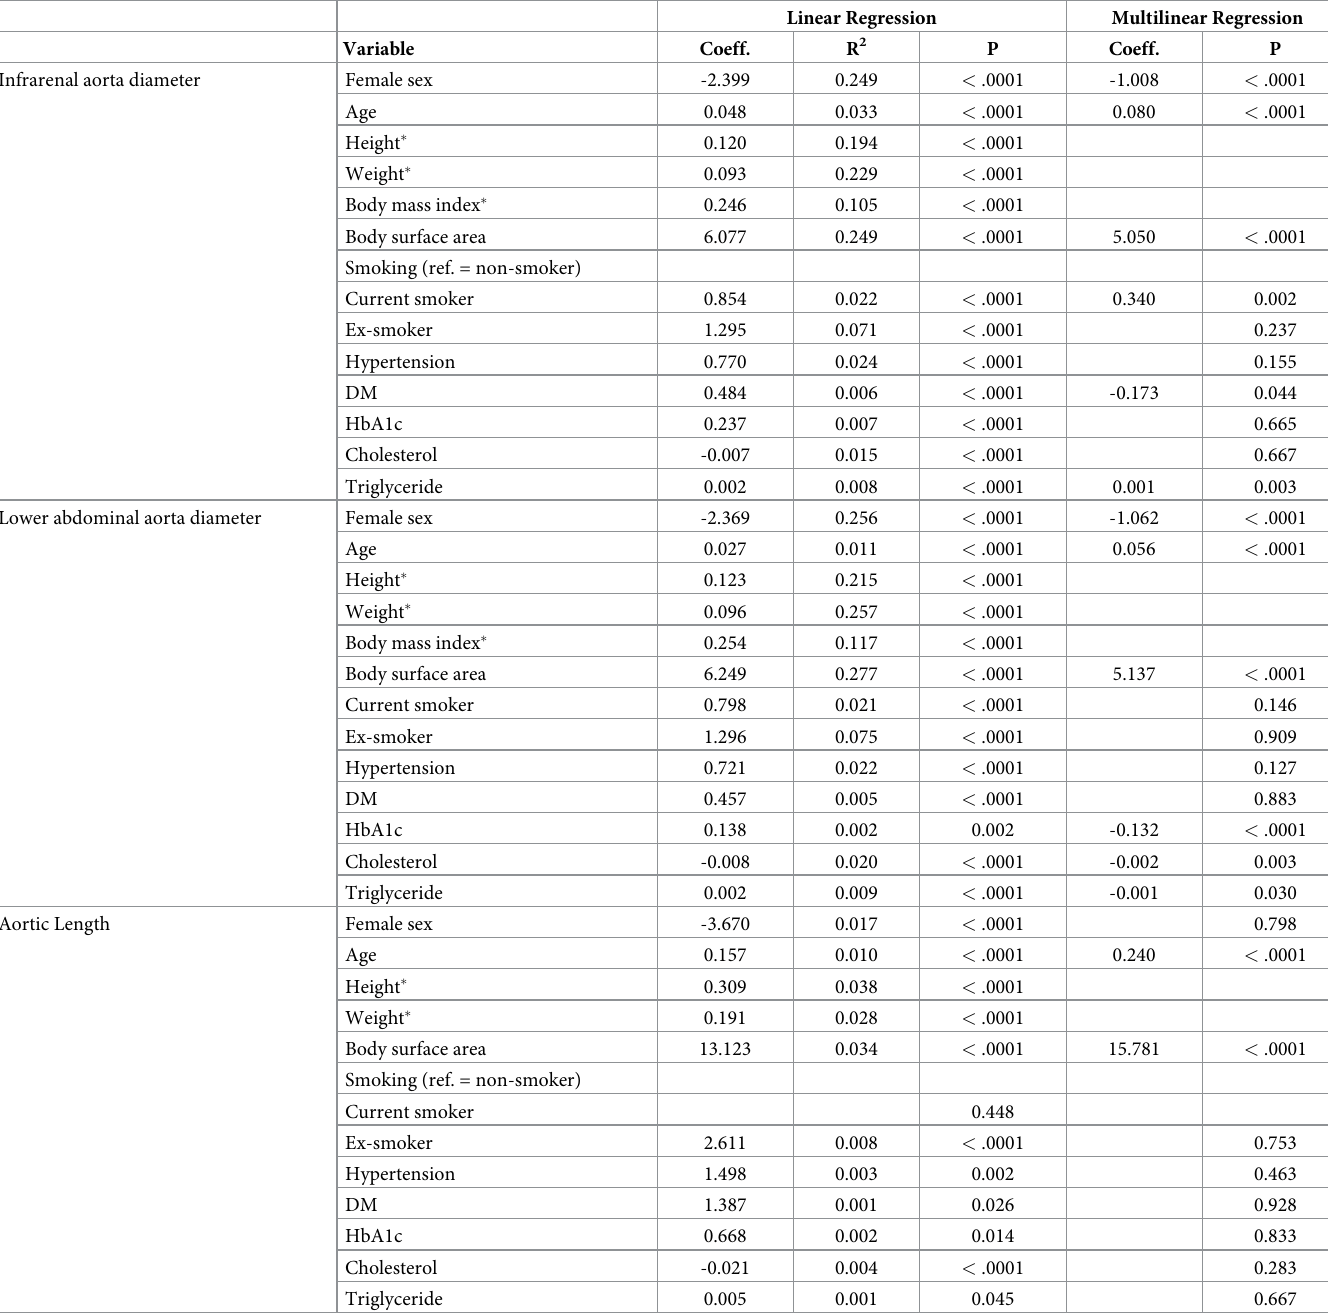
Table 3. Linear and multilinear regression of aortic diameters and lengths with